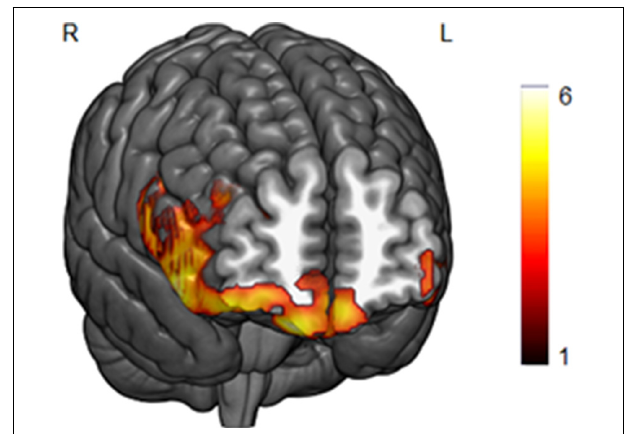
FIGURE 1 | A negative correlation between body mass index (BMI) scores and gray matter (GM) volume in the lateral and medial orbitofrontal cortex in the whole-brain analysis ( p < 0.05, FWE corrected). Bar color represents t -values.